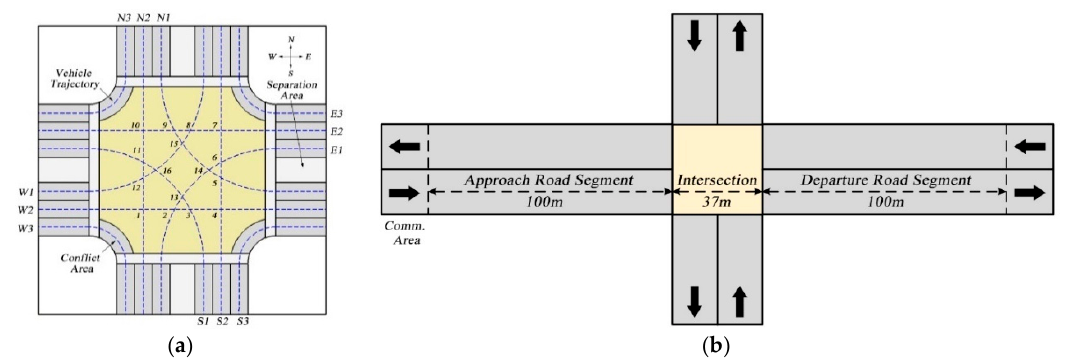
Figure 1. Diagram of the two-way six-lane unsignalized intersection. ( a ) Intersection configuration; ( b ) road segment configuration.